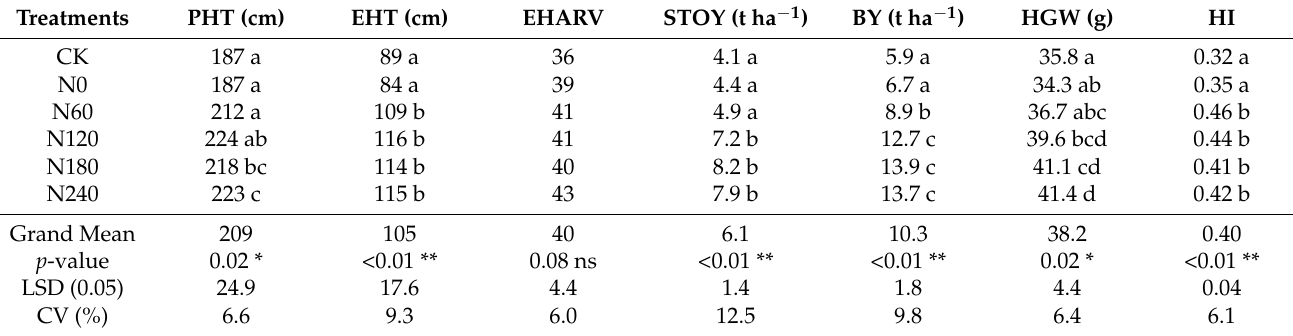
Table 2. Effect of varying N levels on agronomic and yield attributing traits of the Manakamana-3 maize variety under rainfed